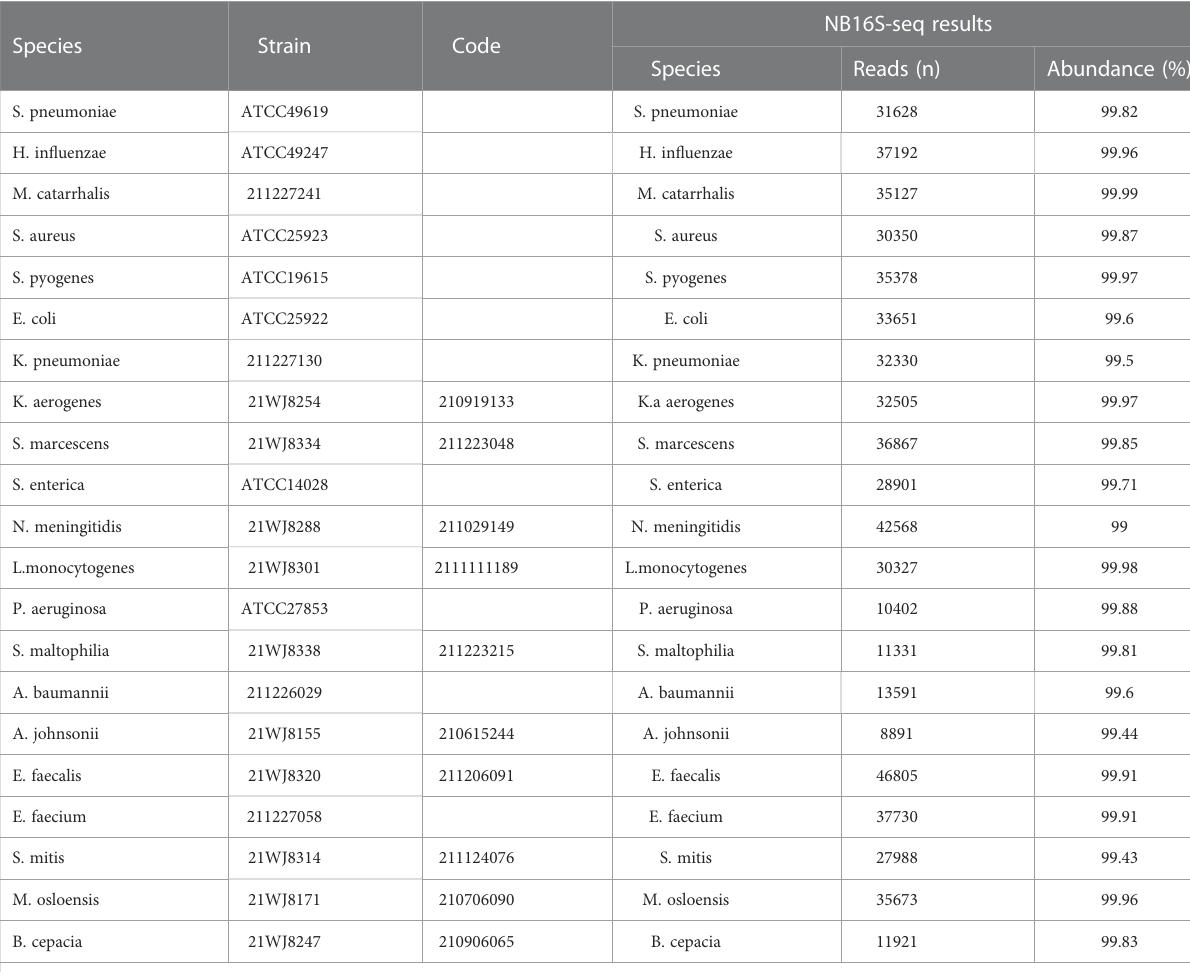
TABLE 1 Evaluating the NB16S-seq test with 21 common respiratory pathogens. Seven reference strains and 14 clinical isolates were used to verify the detection results of the NB16S-seq.